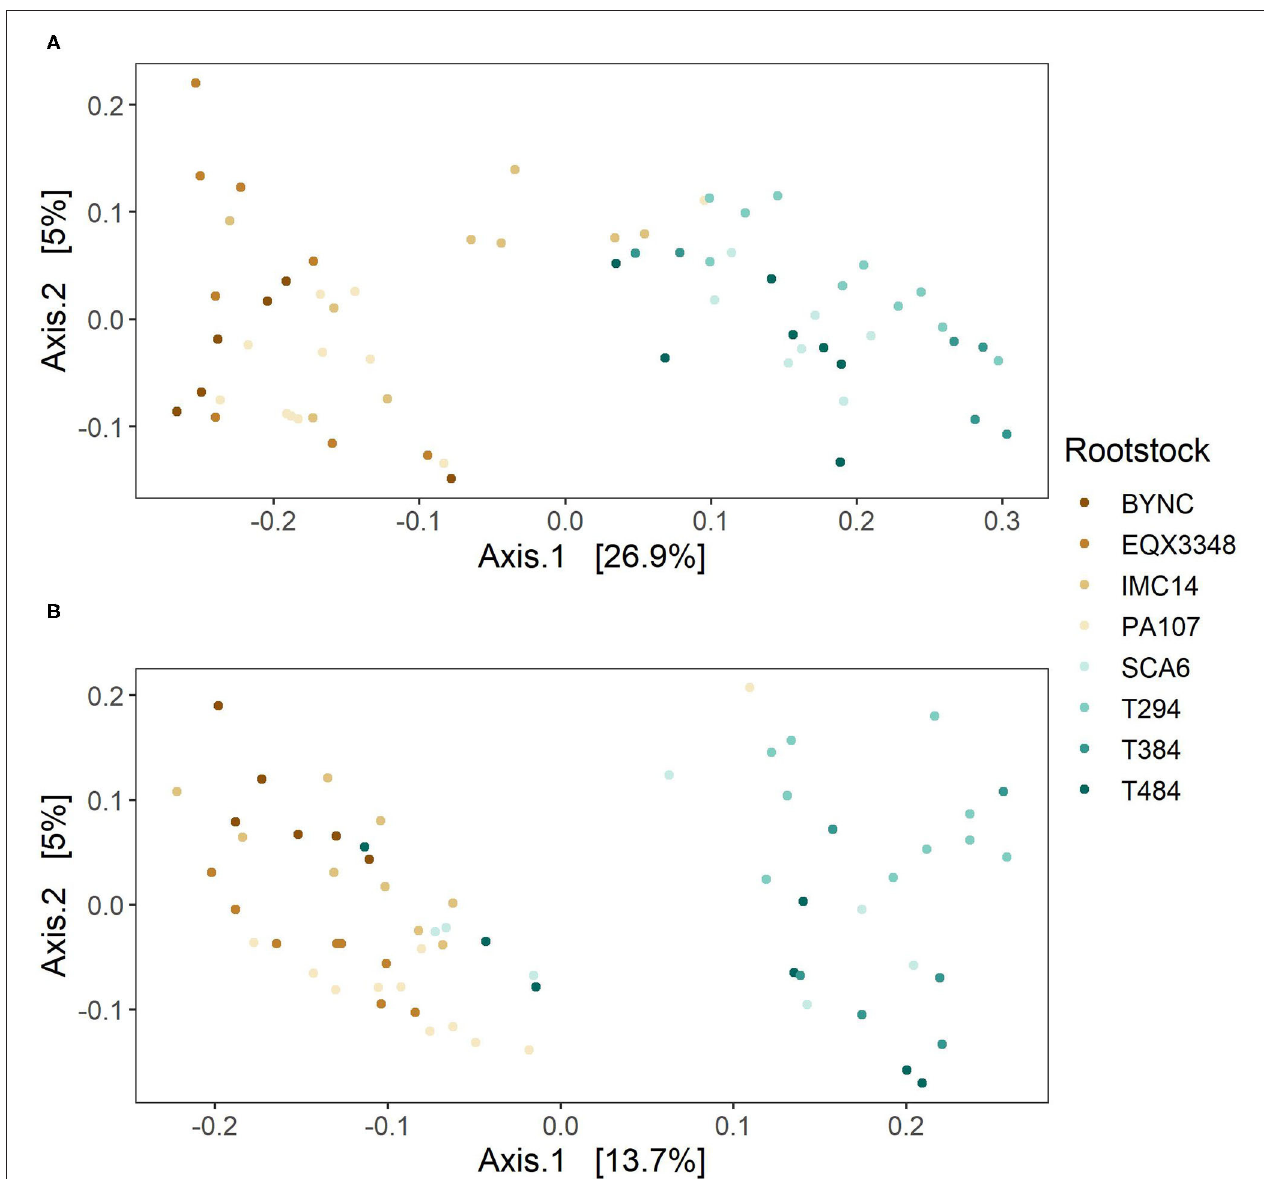
FIGURE 3 | Principal coordinates analysis (PCoA) ordination of rhizobiomes. Separation of (A) bacterial communities and (B) fungal communities by two groups of rootstocks occurred primarily along the first axis, which accounted for 26.9% of variation in bacterial communities and 13.7% of variation in fungal communities. Further clustering by rootstock within each group was evident along the second axis, which accounted for 5% of variation in both bacterial and fungal